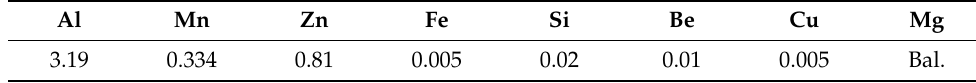
Table 1. Chemical composition of AZ31 magnesium alloy.